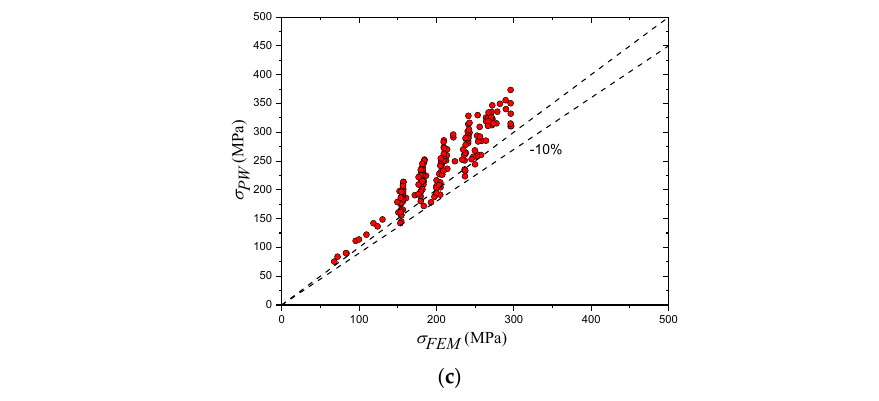
Figure 23. Proposed equation against FEM results. ( a ) Equation vs. FEM (no safety factor); ( b ) Equation vs. FEM (1.10 safety factor); ( c ) Equation vs. FEM (applied load above 60% of cross ‐ sectional capacity)